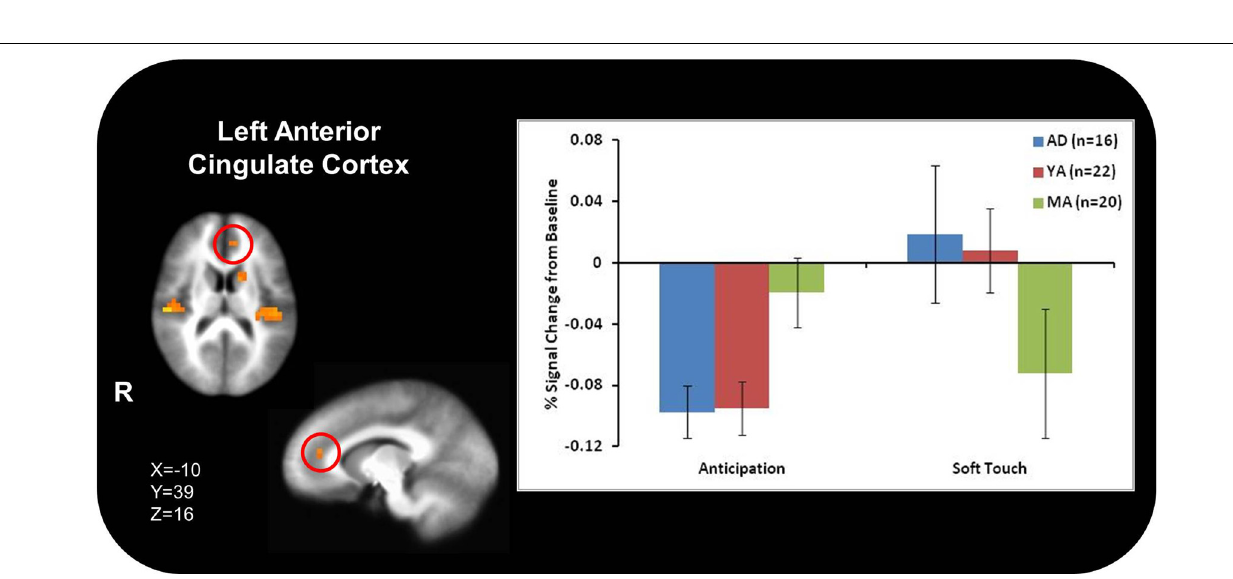
displayed heightened activation. In contrast, mature adults (MA) exhibited comparable attenuation during both anticipation and soft